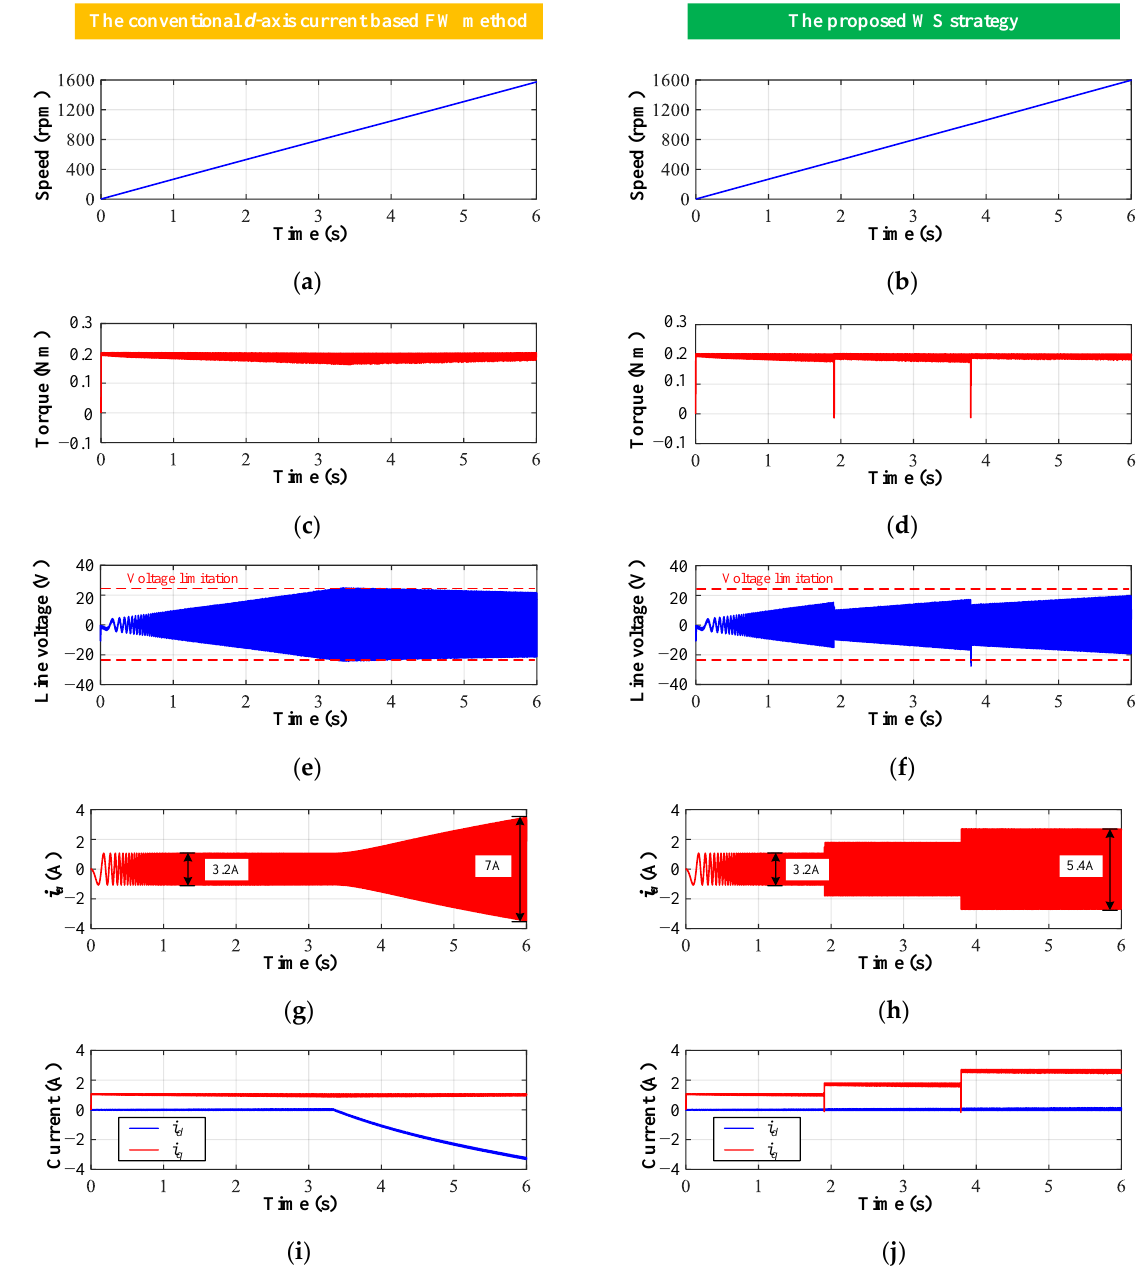
Figure 15. The comparison between the proposed WS strategy and the conventional method. ( a ) Speed curve of the conventional method. ( b ) Speed curve of the WS strategy. ( c ) Torque curve of the conventional method. ( d ) Torque curve of the WS strategy. ( e ) Line voltage of the conventional method. ( f ) Line voltage of the WS strategy. ( g ) Phase current of the conventional method. ( h ) Phase current of the WS strategy. ( i ) The d - and q -axes currents of the conventional method. ( j ) The d - and q -axes currents of the WS strategy.